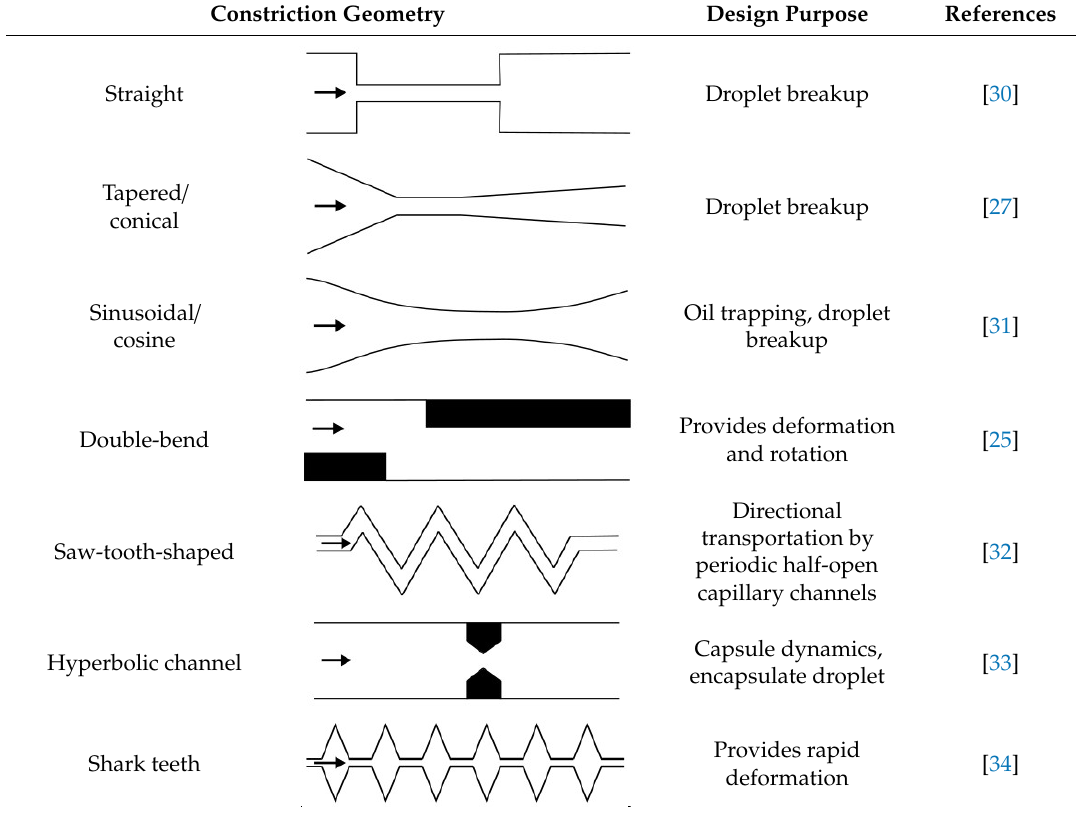
Table 3. Constriction channel geometry designs.